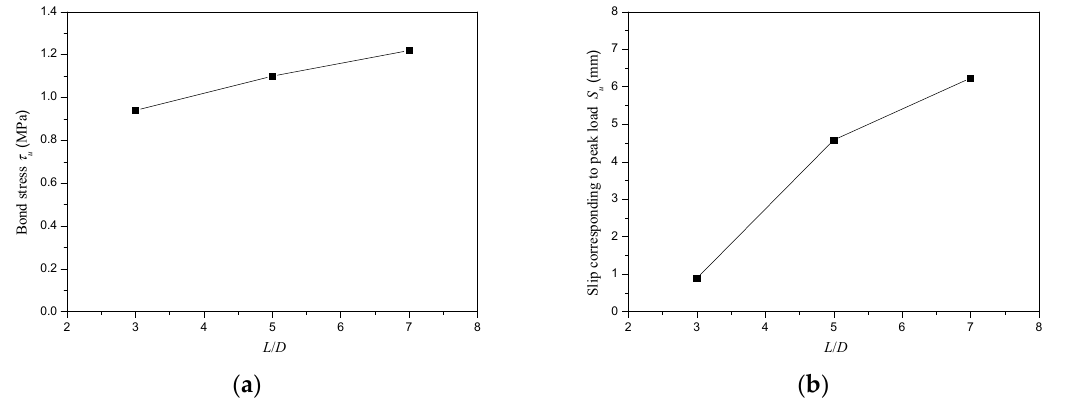
Figure 9. Variation of bond stress ( τ u ) and slip corresponding to peak load ( S u ) with L / D ratio. ( a ) Bond stress ( τ u ); ( b ) Slip corresponding to peak load ( S u ).